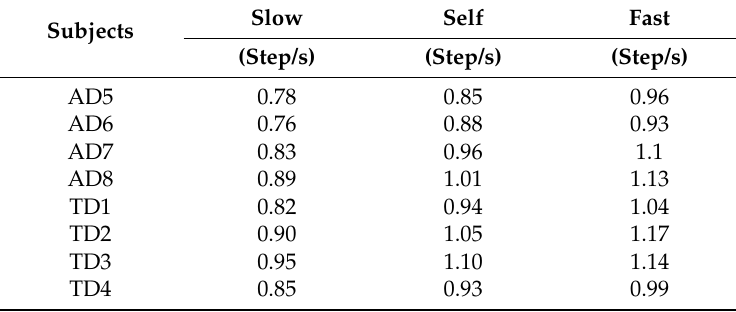
Table 4. Speed information of eight healthy subjects.